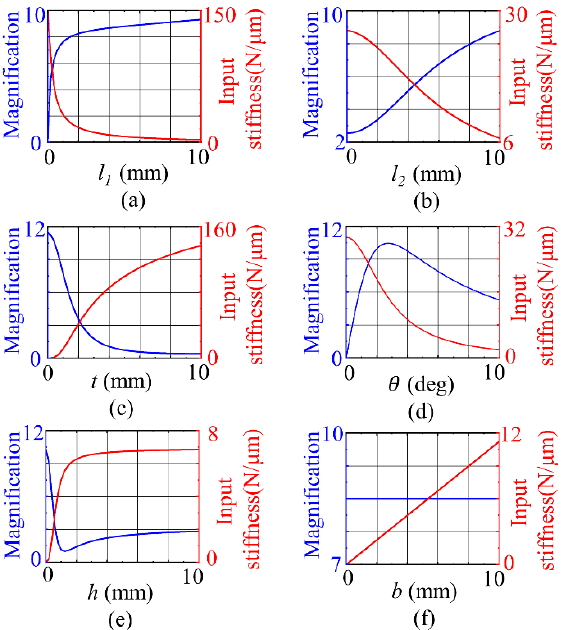
Figure 4. Influence of structural parameters on displacement magnification and input stiffness: ( a ) length of flexure hinge; ( b ) length of rectangular rod; ( c ) thickness of flexure hinge; ( d ) inclination of the line joining the geometric centers of the two flexible hinges; ( e ) thickness of rectangular rod; ( f ) thickness of the bridge mechanism.